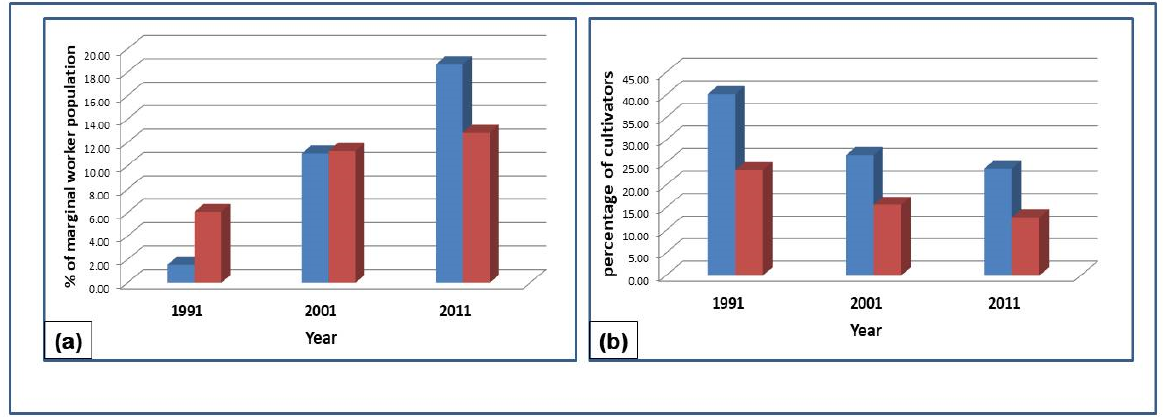
Figure 4. ( a ) Gender-wise percentage of marginal worker population and ( b ) the percentage of cultivator population in the study area (blue bar—male, brown bar—female).